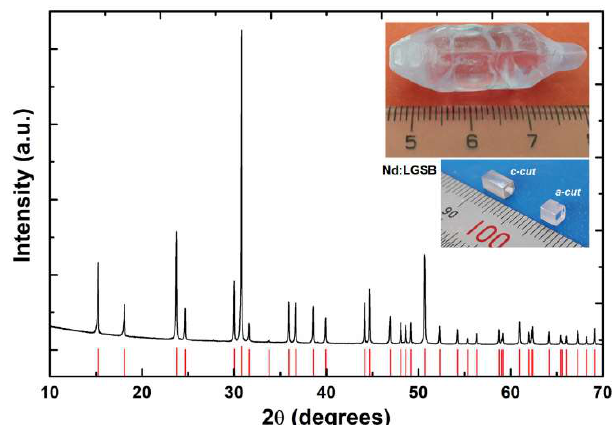
Figure 1. Room temperature XRPD of the Czochralski-grown Nd:LGSB crystal. Red vertical lines correspond to the peaks of R32 trigonal phase (PDF card 04-018-1225). Insets show the grown boule of Nd:LGSB (top) and the Nd:LGSB active elements used in the experiments (bottom).